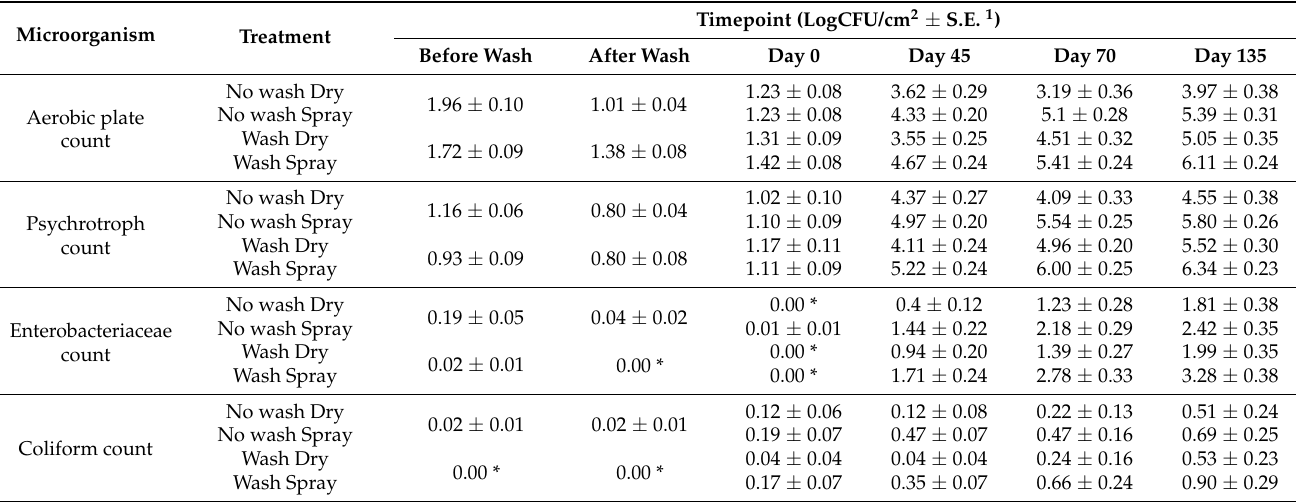
Table 1. Summary table of microbial indicator microorganism counts in striploins before and after the intervention, chilling method, and evaluation at day 0, 45, 70, and 135 of refrigerated storage.